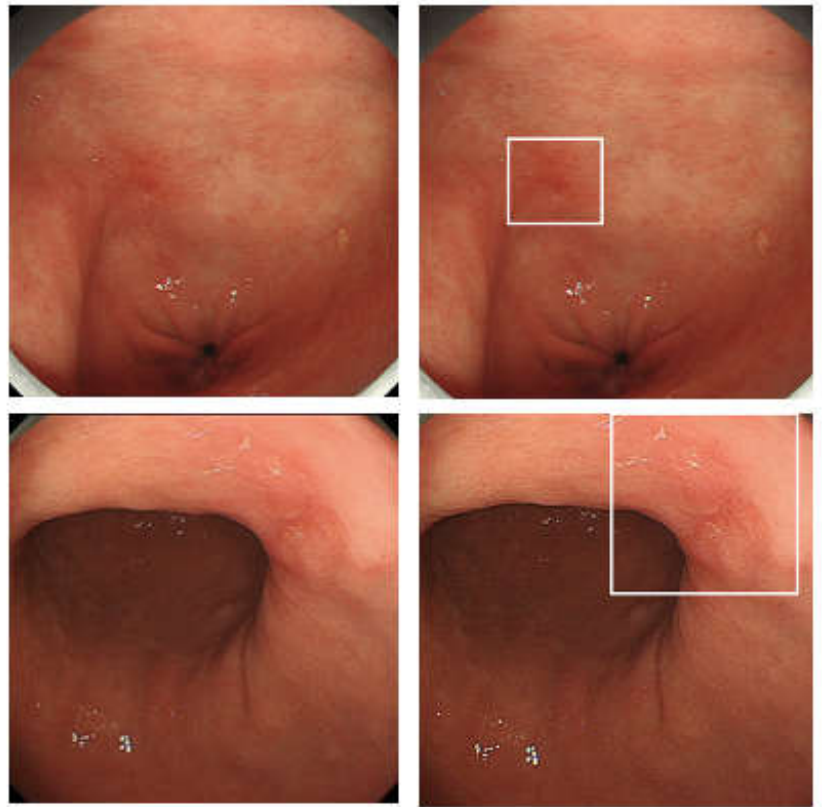
Figure 1. An example of CADe system for gastric cancer. The system supports the detection of gas- tric cancers by displaying a rectangle. CADe: computer-assisted detection.